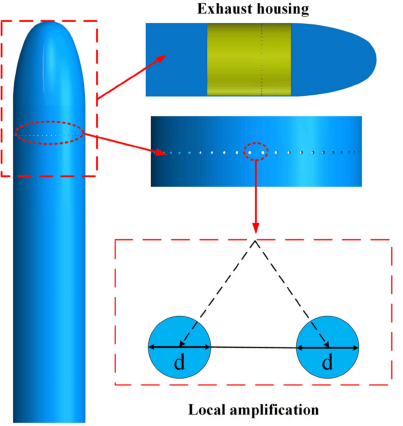
Figure 6. Geometric